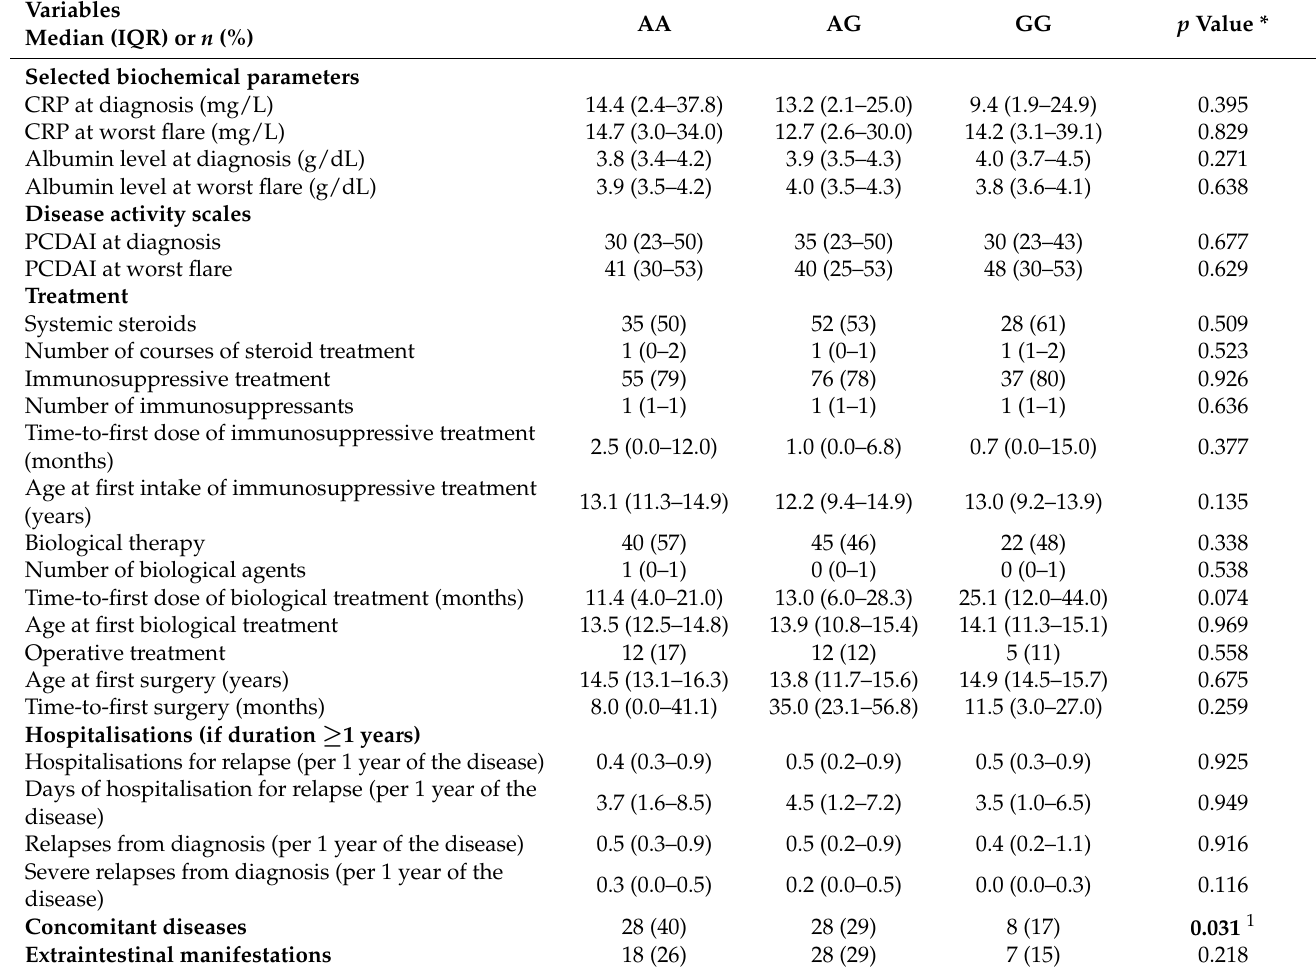
Table 3. Association between DMBT1 rs2981804 genotypes and CD